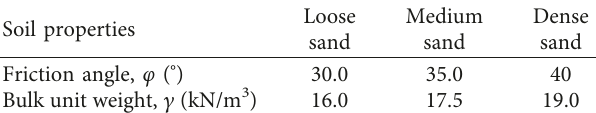
Table 3: Summary of the soil